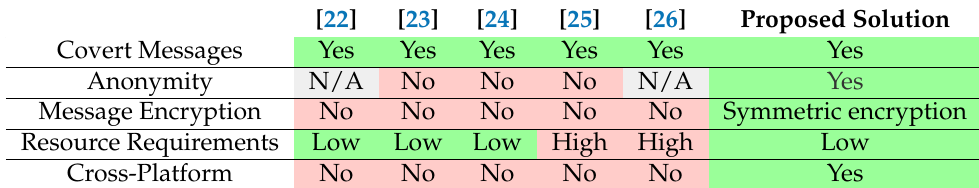
Table 2. Previous work and proposed solution features